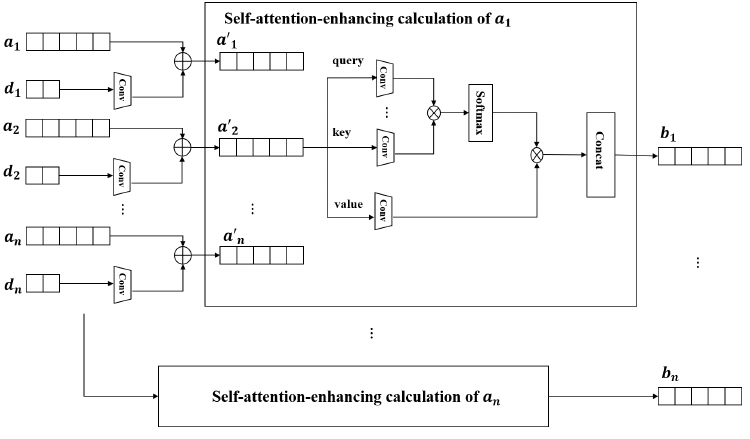
Figure 3. Feature learning